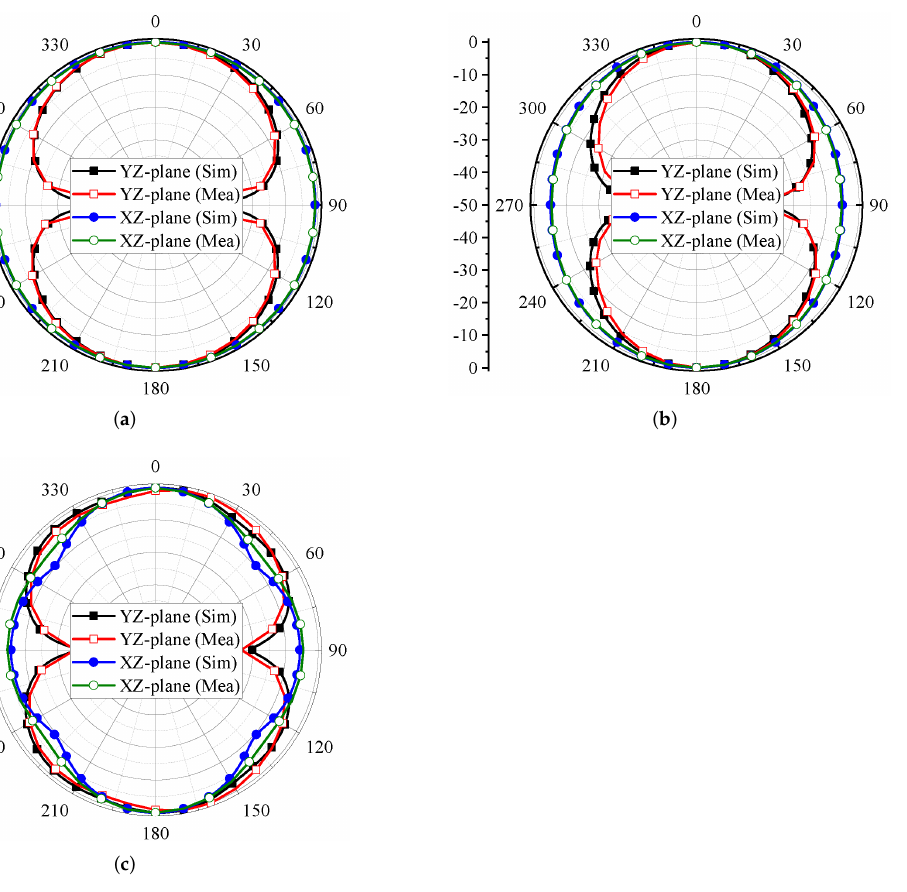
Figure 8. Simulated and measured radiation characteristics of the proposed CPW-fed pentagonal fractal antenna at ( a ) 4 GHz, ( b ) 8 GHz, and ( c ) 12 GHz.